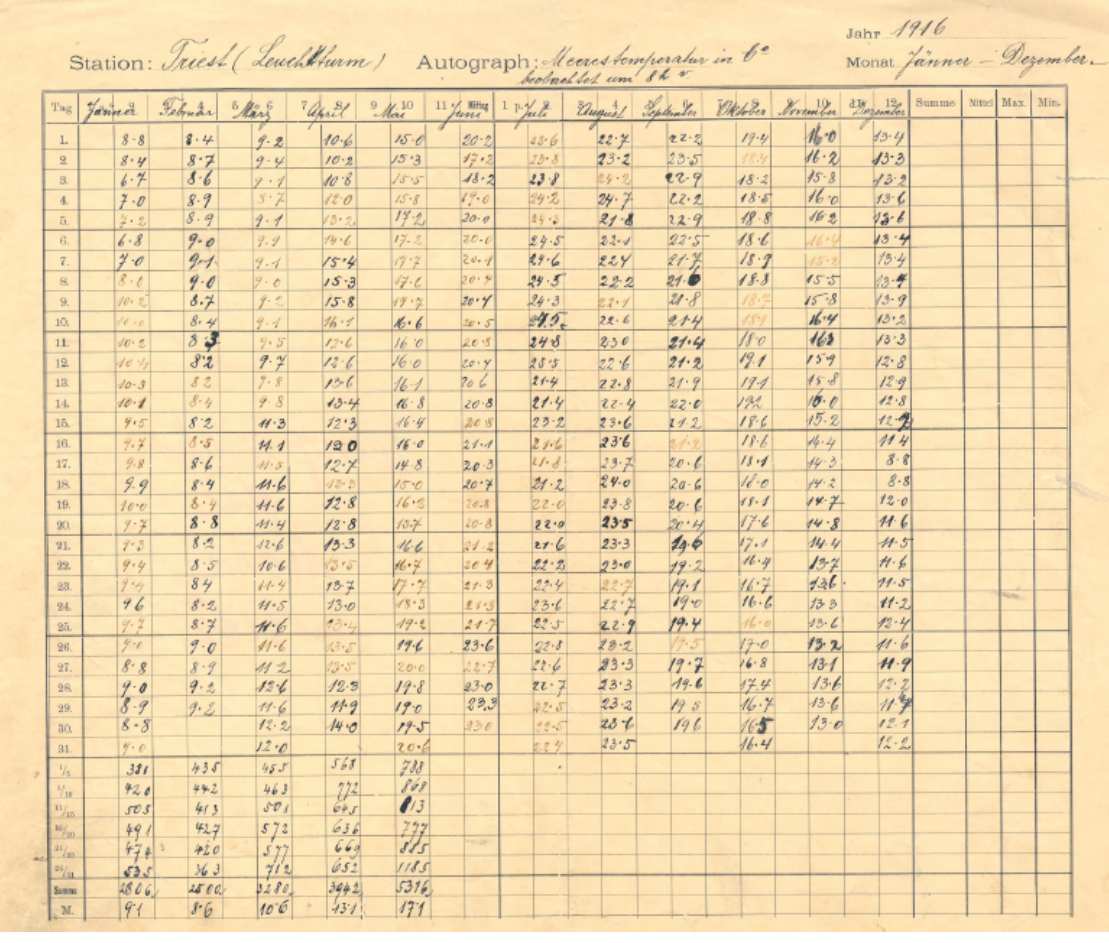
Figure 3. Sea temperature summary sheet for 1916. On top, the indication of site and observation time: the temperature was measured at Trieste lighthouse in degrees Celsius at